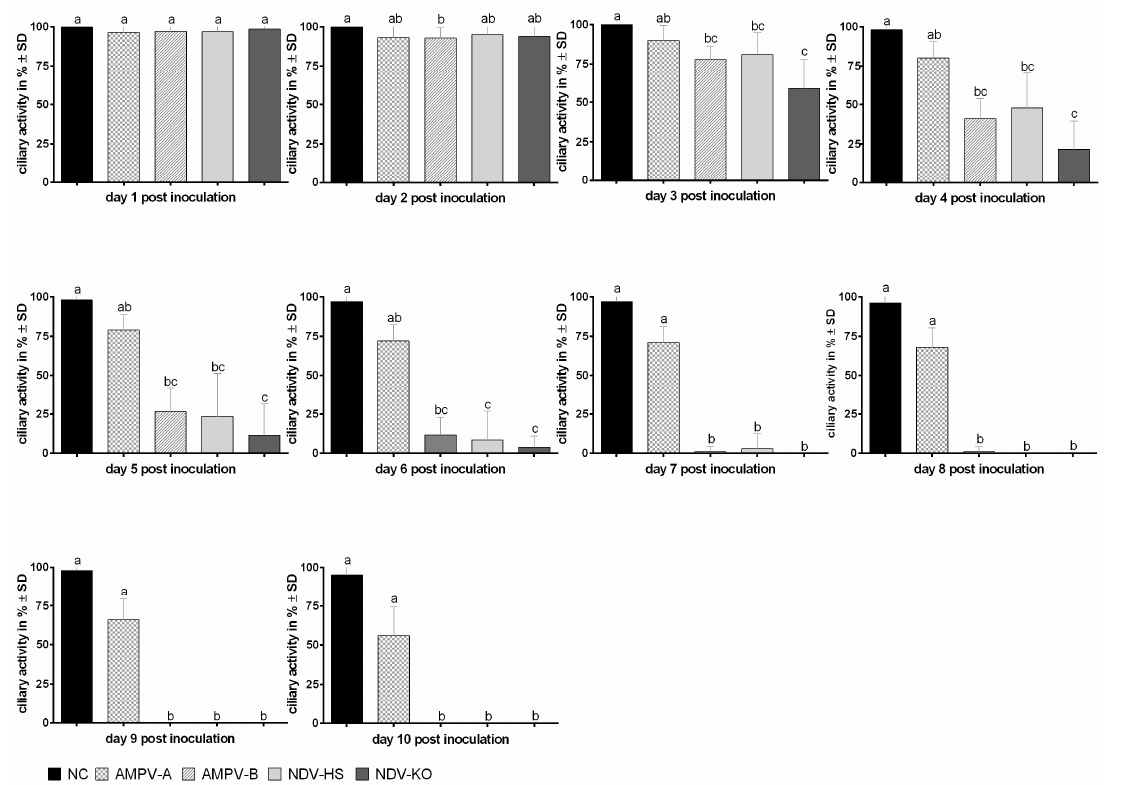
Figure 4. Ciliostasis in TOCs after inoculation with either AMPV-A, AMPV-B, NDV-KO, or NDV-HS. The daily average ciliary activity for ten TOCs per group is displayed. Error bars indicate standard deviations (SD). Small le tt ers represent signi fi cant di ff erences between the four di ff erent virus strains and the negative control at the same time points, at p < 0.05, using the Kruskal–Wallis all-pairwise comparison test. Graphs represent data from one representative experiment.